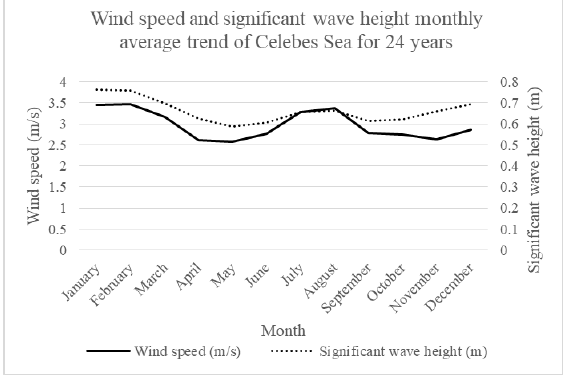
Figure 10. Monthly trend of wind speed and significant wave height for Celebes Sea.